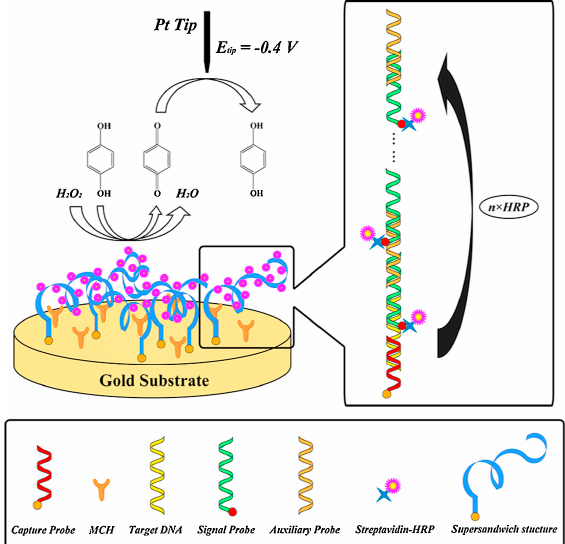
Figure 9 . Schematic of the fabrication and SECM detection of the proposed DNA biosensing platform. Copyright (2016) Elsevier Ltd.